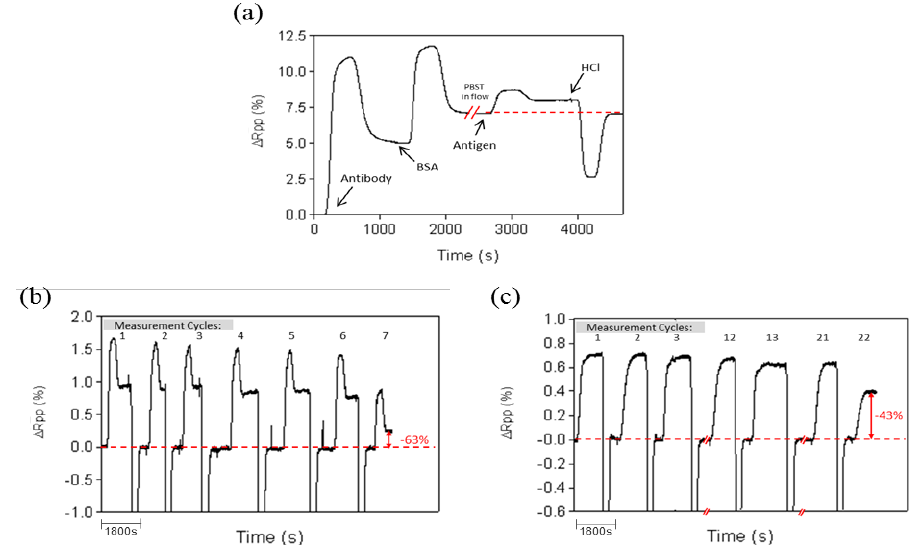
Figure 4. ( a ) Sensogram of biosensing measurement with ProLinker™-coated surface: antibody immobilization (anti-CRP 10 µg/mL), blocking step (BSA 1 mg/mL), antigen detection (CRP 1 µg/mL) and regeneration (HCl 5 mM); ( b ) Detection cycles